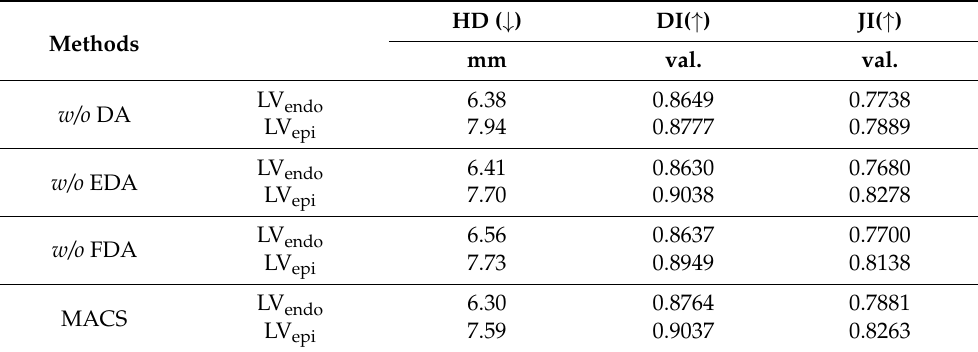
Table 1. Ablation studies on the proposed MACS. The fully domain adaptation (DA), entropy domain adaptation (EDA) and feature domain adaptation (FDA) are ablated, respectively. The up arrow indicates expecting a higher value.